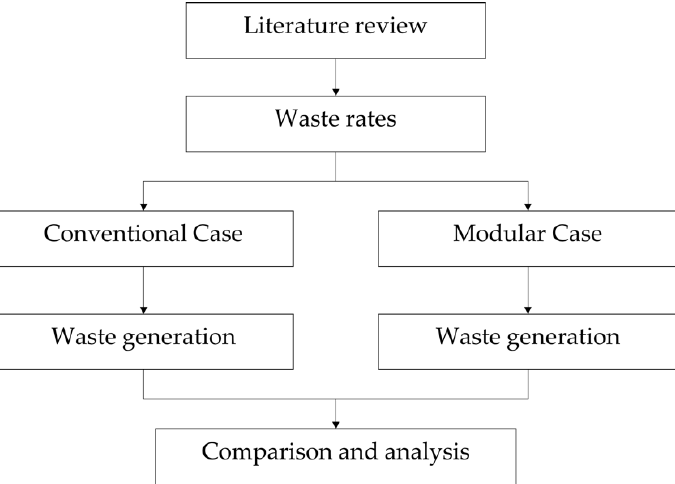
Figure 1 . The research framework developed for waste generation